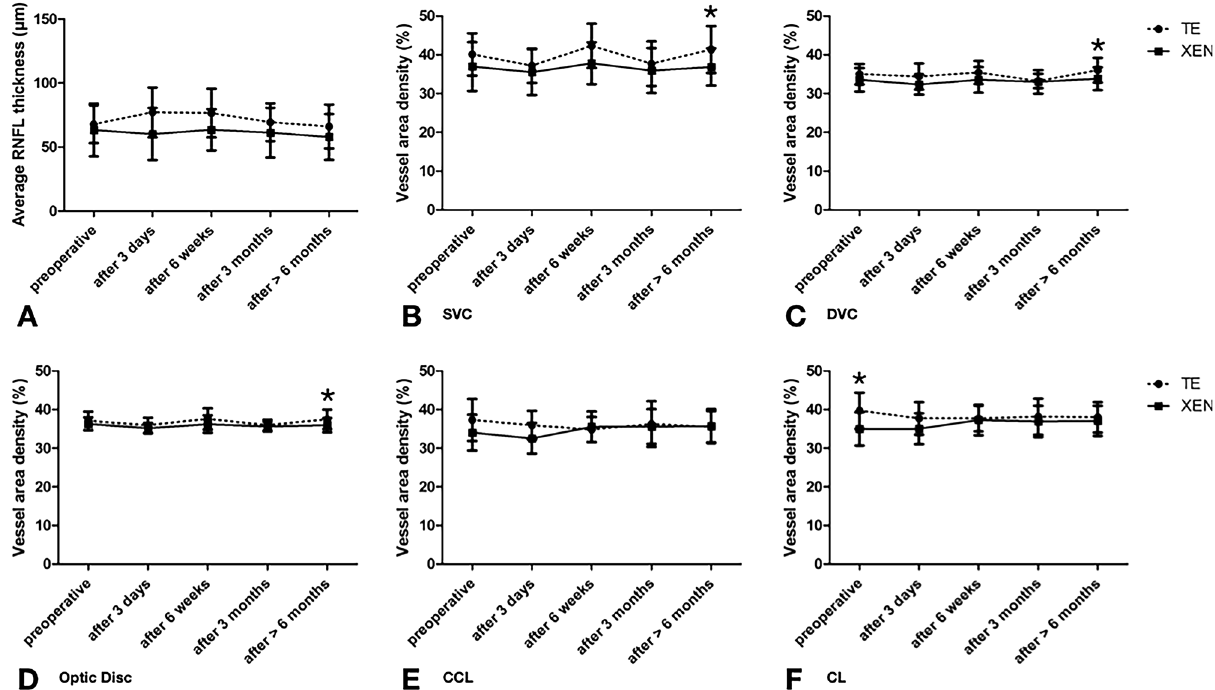
Figure 5. Change in ( A ) average RNFL thickness (in µm), ( B ) SVC superficial vascular complex (in percentage), ( C ) DVC deep vascular complex (in percentage), ( D ) optic disc (in percentage), ( E ) CCL choriocapillaris layer (in percentage) and ( F ) CL chorioideal layer (in percentage) for the follow-up intervals. *marked significant differences between both treatment groups.